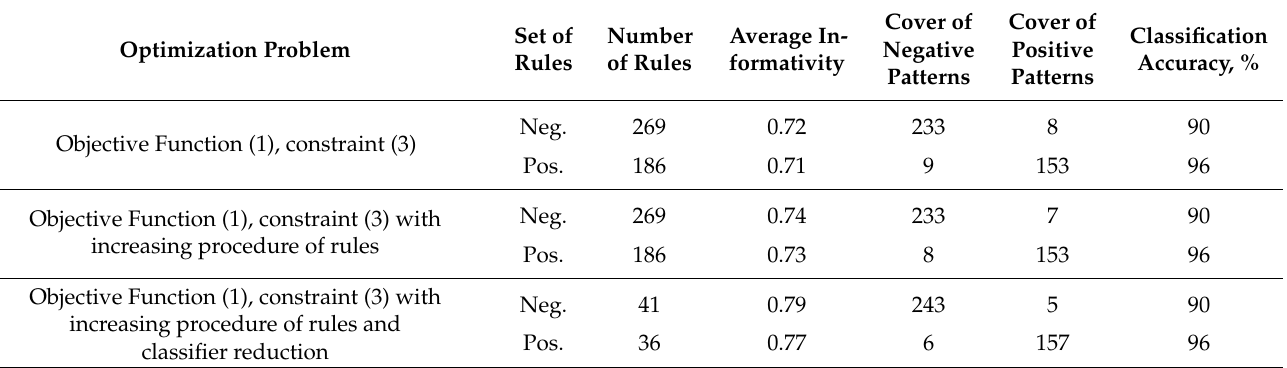
Table 5. Experimental study of the classifier reduction procedure for the problem of breast cancer diagnosis.